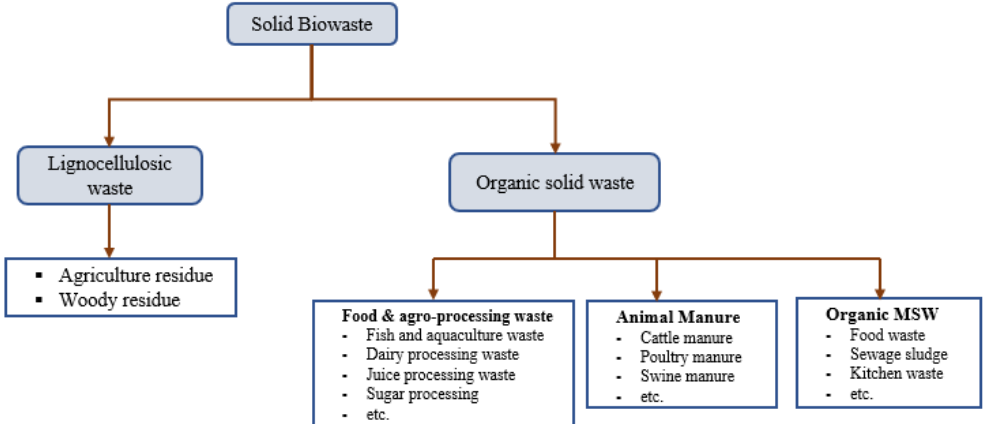
Figure 2. Classification of solid biomass waste.